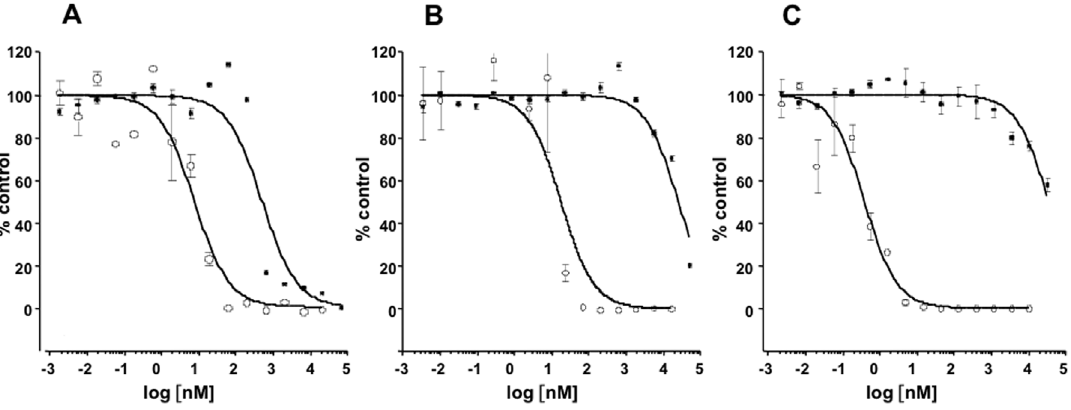
Figure 3. Comparison of anti-HCV activities of GRFT, CV-N and SVN against JFH-1. Anti-HCV activities were evaluated by JFH-1 HCVcc full- replication assay, by measuring HCV core protein output in the culture supernatants of Huh7.5.1 cells 72 hr post-infection. The cytotoxicity was evaluated in parallel using WST-8 assay. The HCV output (open circle) and cell viability (closed square) were plotted as percentage (%) relative to control infections without CV-N (A), SVN (B) or GRFT (C). Compounds were added 15 min prior to viral challenge. Results are expressed as mean and standard deviation from triplicate experiments.